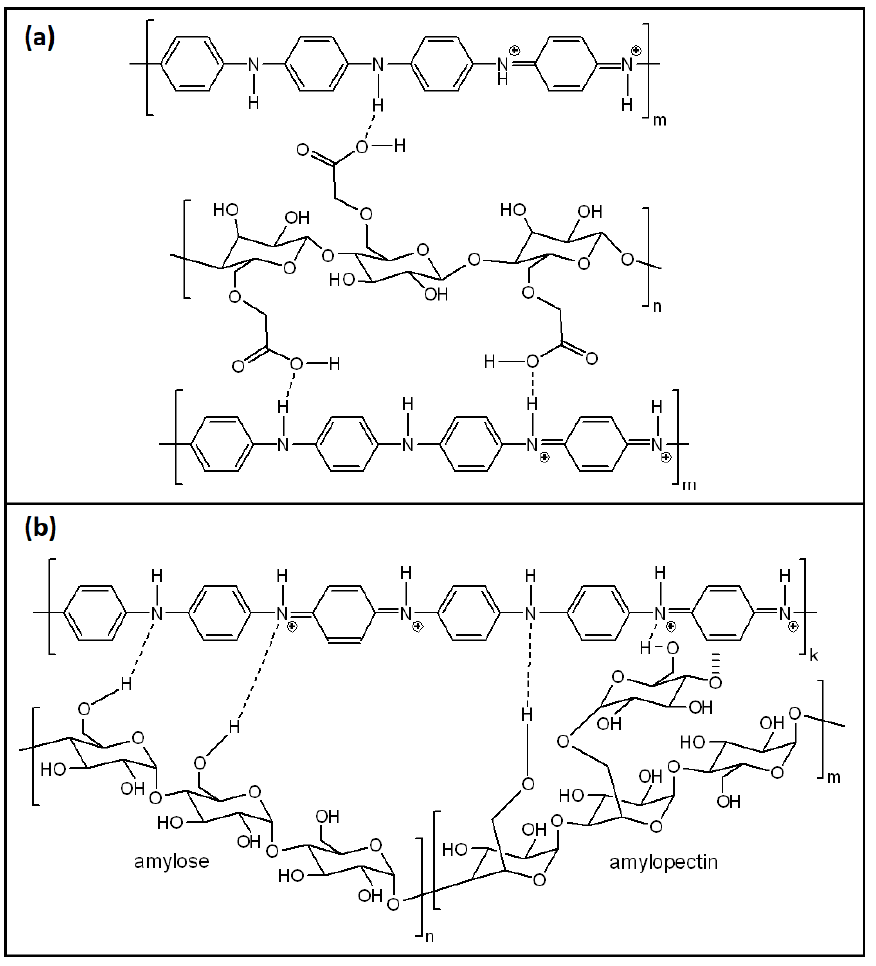
Figure 12. Schematic representation of polymer structures: ( a ) PANI/CMC composite; and ( b ) PANI/STR composite. The terms “m” and “n” refer to the degree of polymerization for the amylopectin and amylose segments, respectively. Based on the results from [124,139].